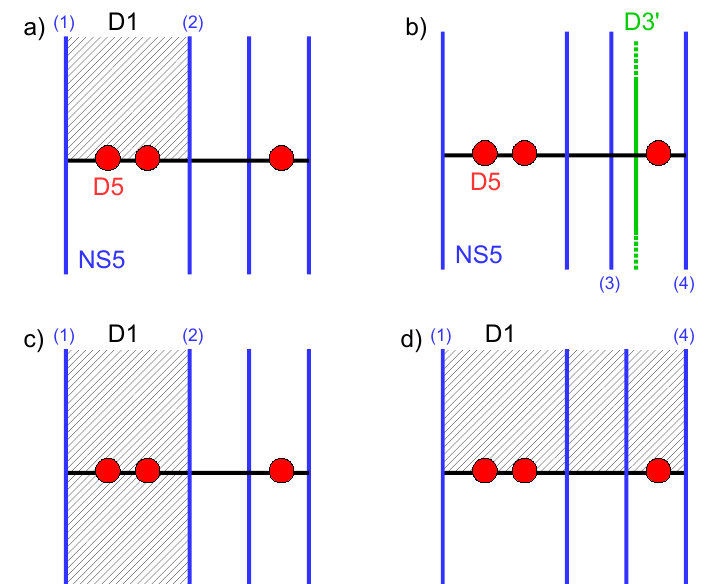
Figure 30 . Brane setups inserting the CB operators of theory B: a) V + or ( m 1 (cid:0) ’ 1 )( m 2 (cid:0) ’ 2 )( ’ 2 (cid:0) ’ 1 ); d) V +